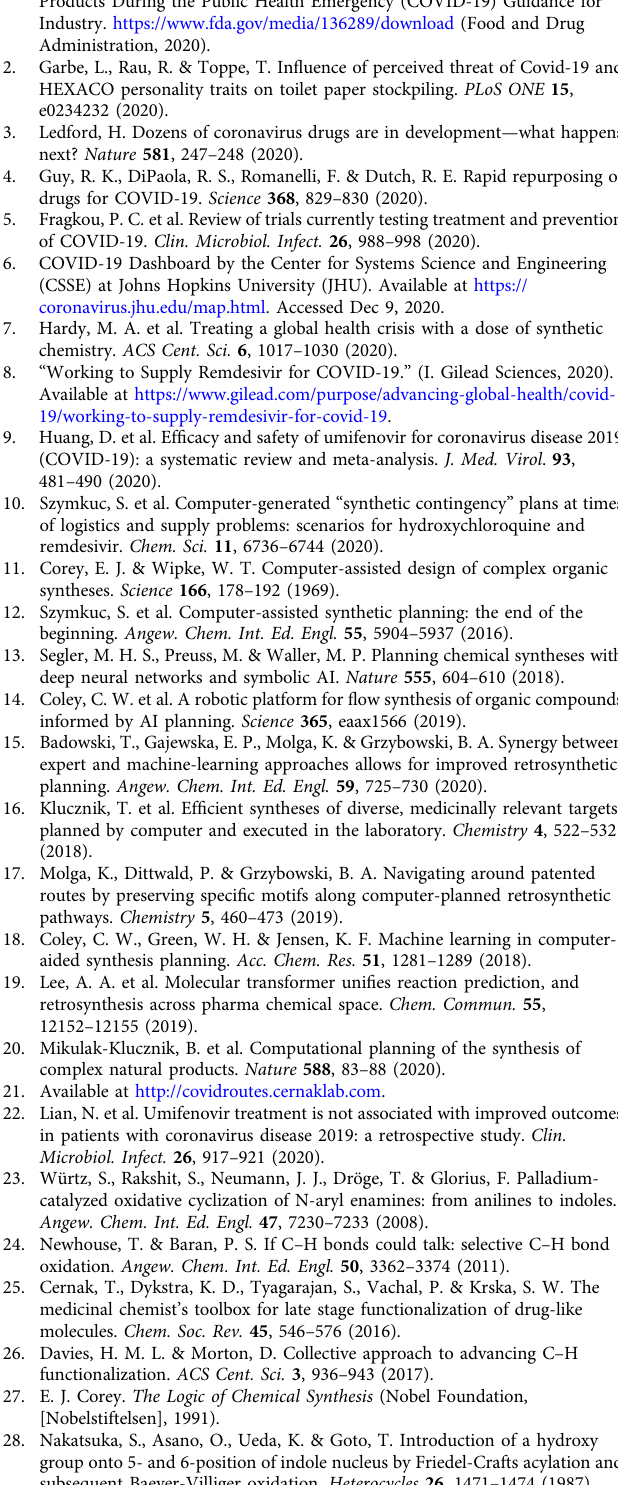
Raw data and experimental procedures are available in the Supplementary Information. The collection of patents, publications, and SMILES strings of starting materials and intermediates used as exclusion criteria for searches in the commercial software SYNTHIA TM are available as an interactive visualizer at http:// covidroutes.cernaklab.com/.